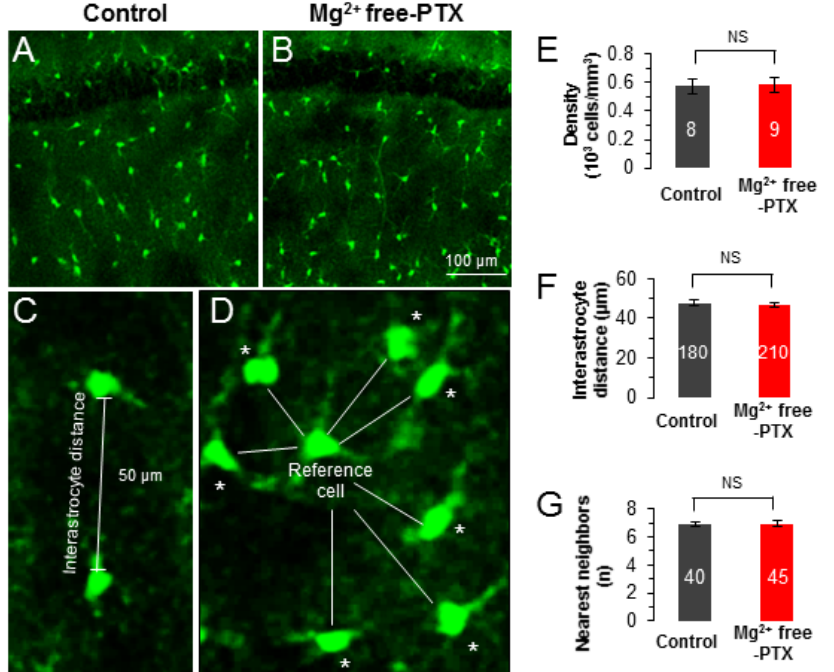
Figure 2. Acute exposure to Mg 2 + free-PTX conditions does not alter the anatomy of astrocyte syncytium. ( A , B ) Confocal image of astrocyte networks in CA1 region from ALDH1L1-eGFP mouse of control group ( A ) and Mg 2 + free-PTX group ( B ). The scale bar in ( B ) also applies to ( A ) ( C , D ) Representations of astrocyte syncytium anatomical parameters: interastrocyte distance and the nearest neighbors as indicated by asterisk (*). ( E – G ) Compared with the control group, no obvious di ff erences in cell density ( E ), interastrocyte distance ( F ) and the number of nearest neighbors ( G ) were observed after treatment with Mg 2 + free-PTX. The numbers inside the bar graphs indicate the hemisphere brain slices in ( E ), the counted pair of astrocytes in ( F ), the counted reference cells in ( G ), from 3 mice in each group. NS: p ≥ 0.05.